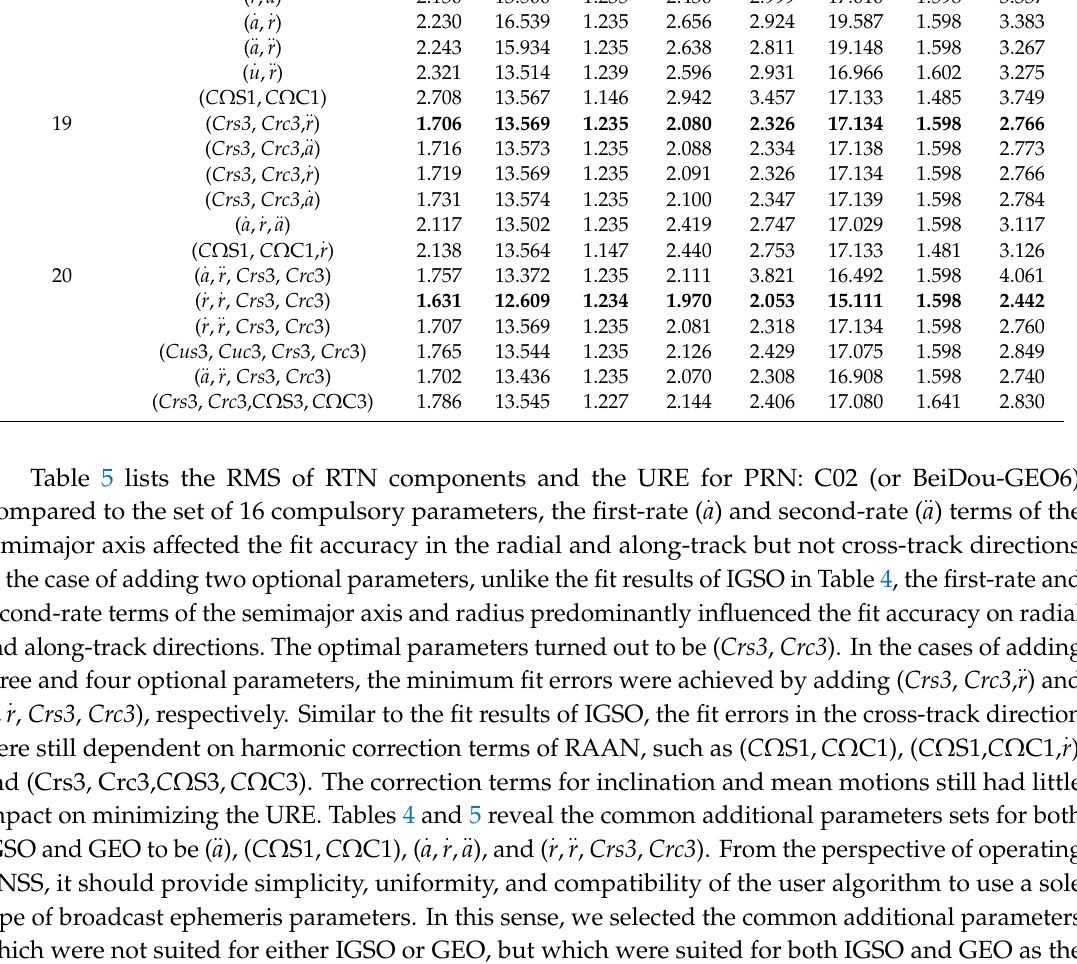
Table 5. Fit URE and RMS fit errors in radial, along-track, and cross-track directions with 2 and 3 h fit intervals for GEO satellite (BeiDou PRN: C02). The parts in bold represent the best fit URE for the same number of parameters.